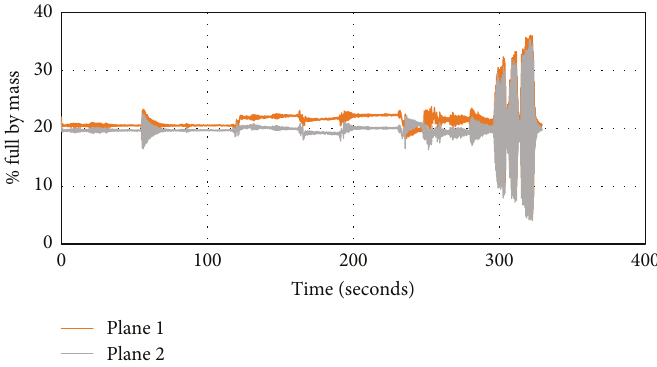
Figure 10: Total mass (0.2 =20% full) in the two tank halves. Sloshing between the two halves, plane 1 and plane 2 are shown clearly.